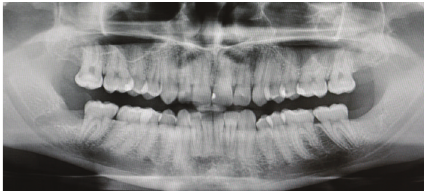
Figure 1: Preoperative orthopantograph (OPG) demonstrating the mesioangular impaction of the lower right third molar.